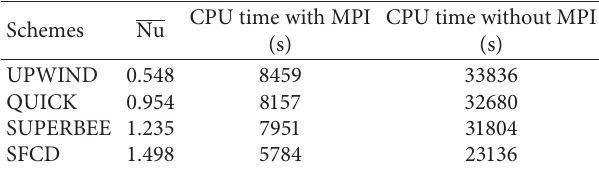
Table 1: Test comparison of convective differencing schemes for the flow in 2D cavity when Re � 400 and Ri � 1.